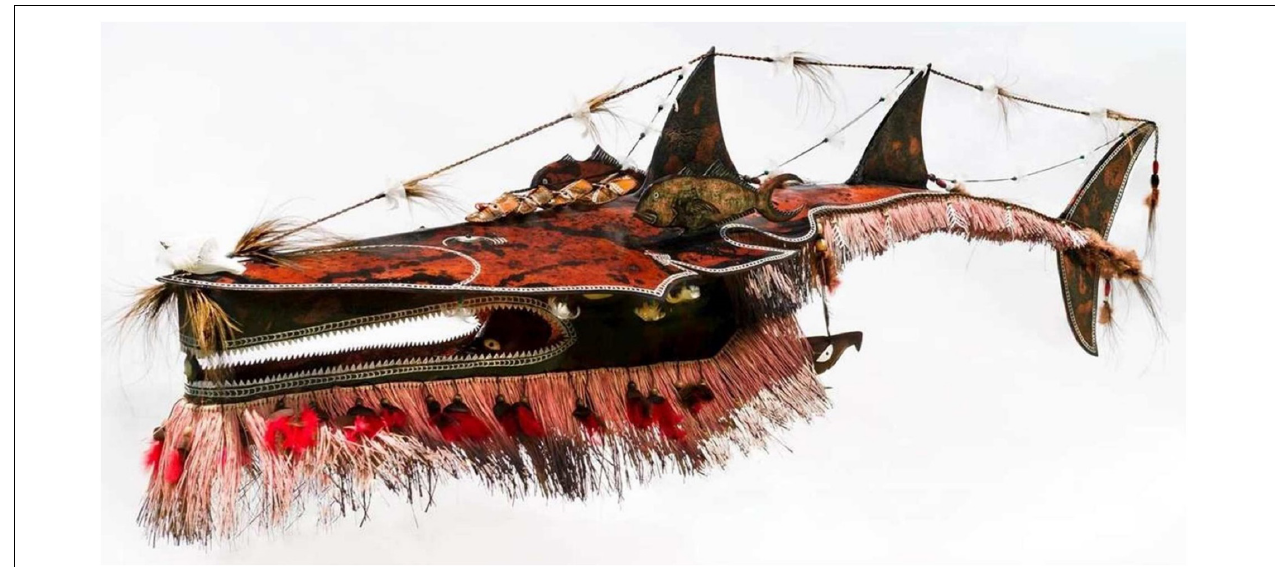
FIGURE 2 | ‘Kaygasiw Usul’. The sculpture references star constellations and their relation to the movements of the shovel-nosed shark. Australian National Maritime Museum (ANMM) Collection Sydney/Alick Tipoti/AAPN. Alick Tipoti is a world reknown professional artist from Badu Island in the Torres Strait. His work depicts many meaningful symbols about the Land, Sea and Sky of his country through traditional Melanesian patterns.